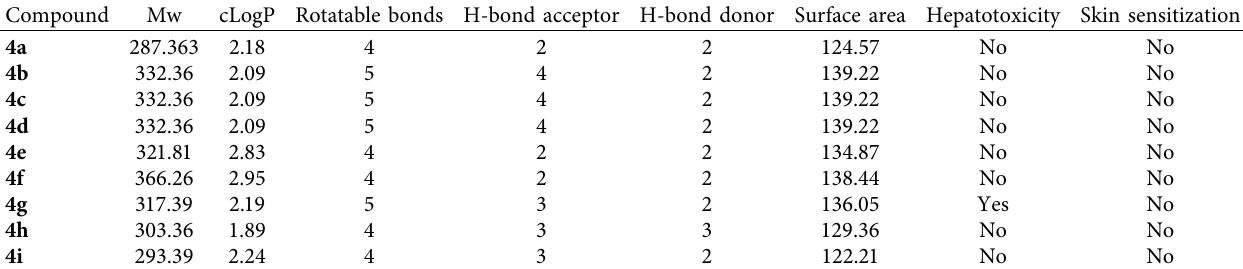
Table 3: Calculated molecular profile for synthesized compounds 4a-i Compound